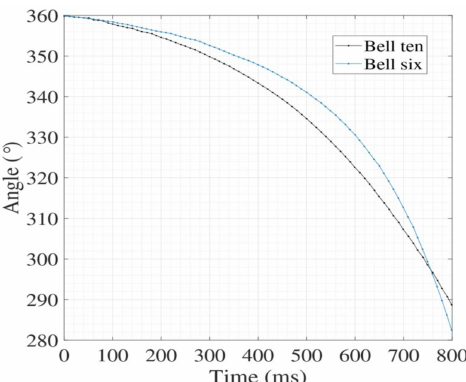
Figure 10. The angular rotation of bell ten and six at the beginning of the hand stroke where the ringer pulls upon the rope to displace the bell from its mouth-up